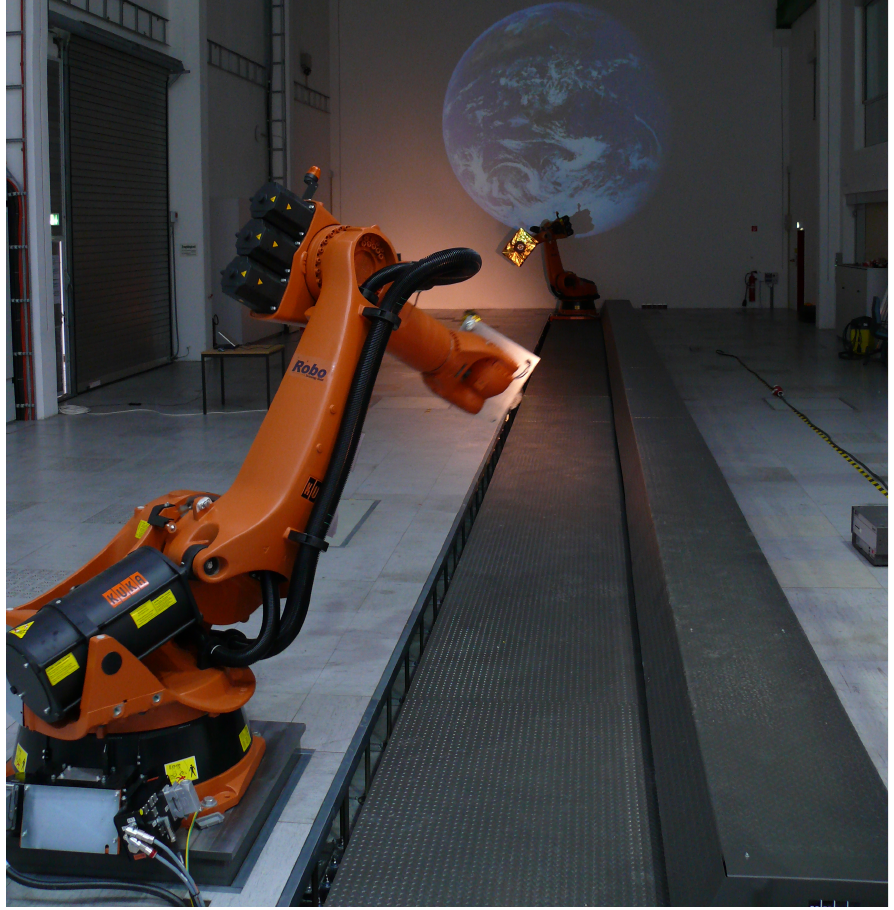
Figure 3. EPOS 2.0 laboratory in 2009. Background: robot 1 mounted on a 25 m linear rail. Left: robot 2 fixed to the laboratory